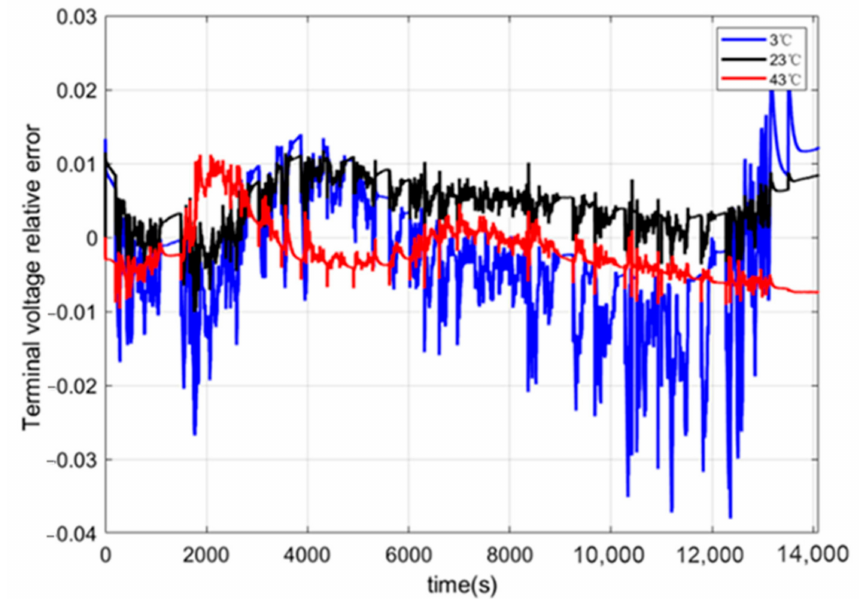
Figure 14. Terminal voltage error on the optimized model for